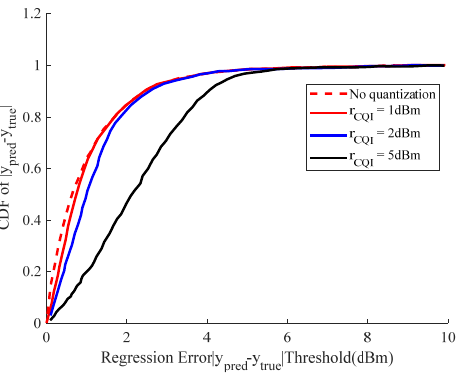
(cid:12) (cid:12) (cid:12) (cid:12) − y true (cid:12) y pred (cid:12) to quantization granularity ( r CQI